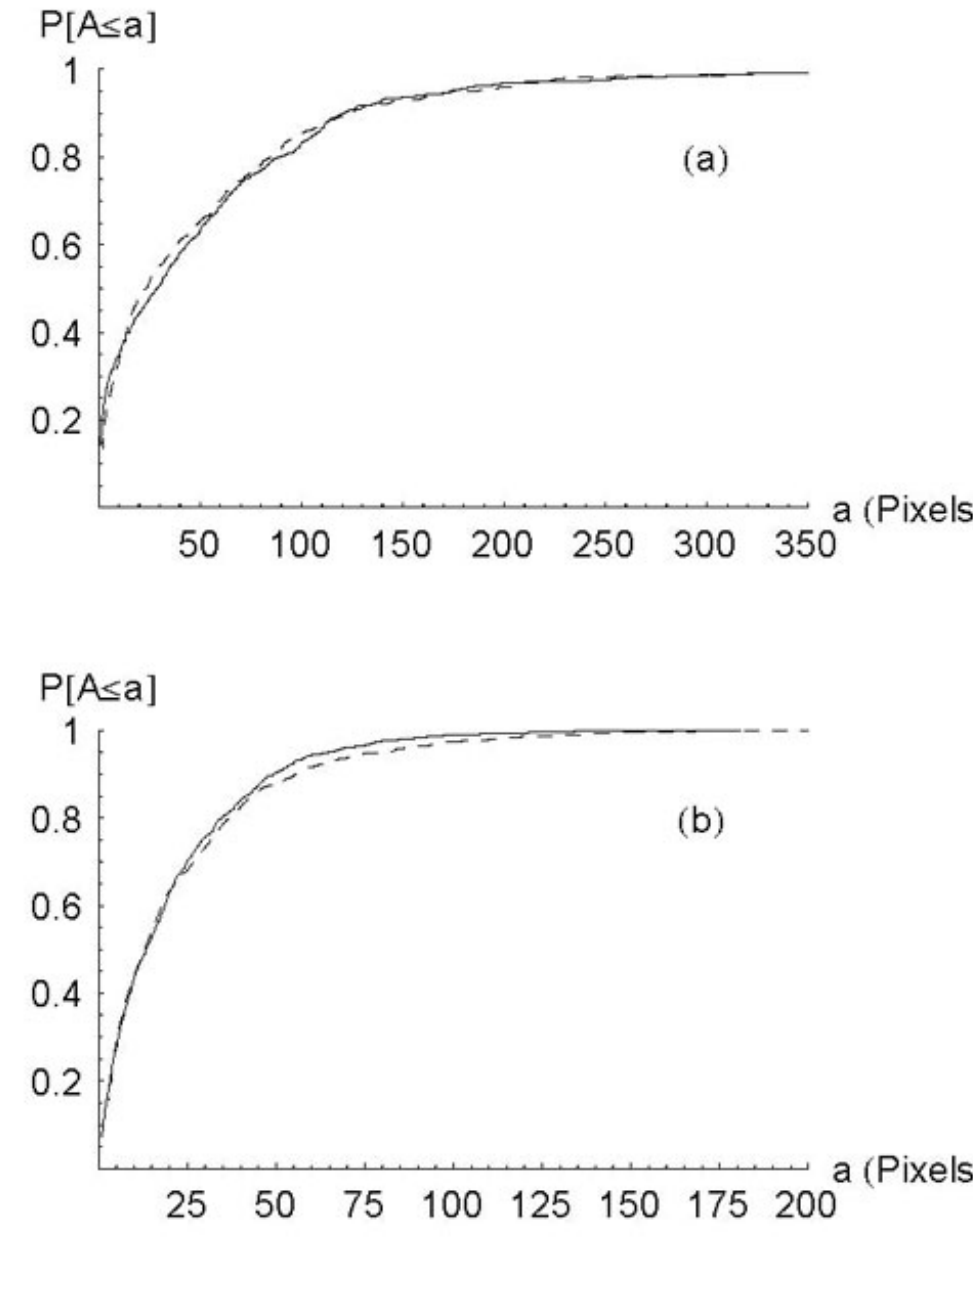
Fig. 3. (a) Cumulative distribution of cluster areas, A, determined for the shrub vegetation shown in Fig. 2a, b. (b) Distributions of cluster areas calculated for the vegetated areas shown in Fig. 2c, d. The distributions obtained for model-simulated vegetation patterns (Fig. 2a,c) closely match those observed in two examples of shrubland ecosystems (Fig. 2b,